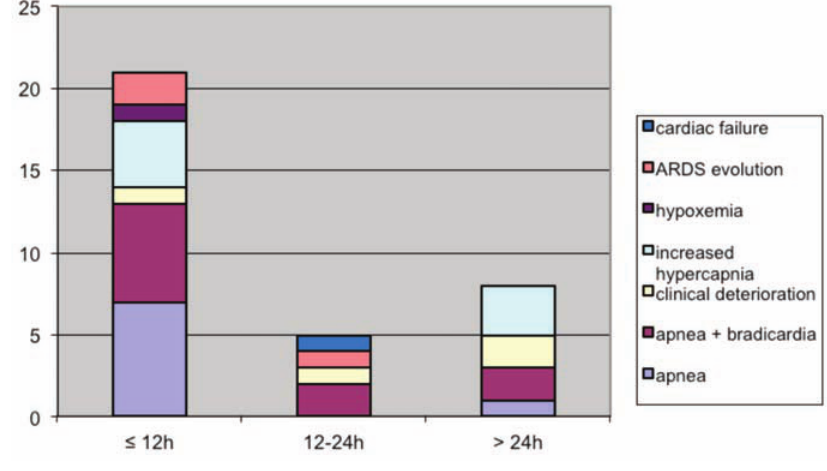
Figure 1. Timing and reasons for endotracheal intubation. (n=34). Non-invasive ventila- tion failure ≤ 12 h = 21; 12-24 h = 5; > 24 h = 8; ARDS, Acute respiratory distress syn-